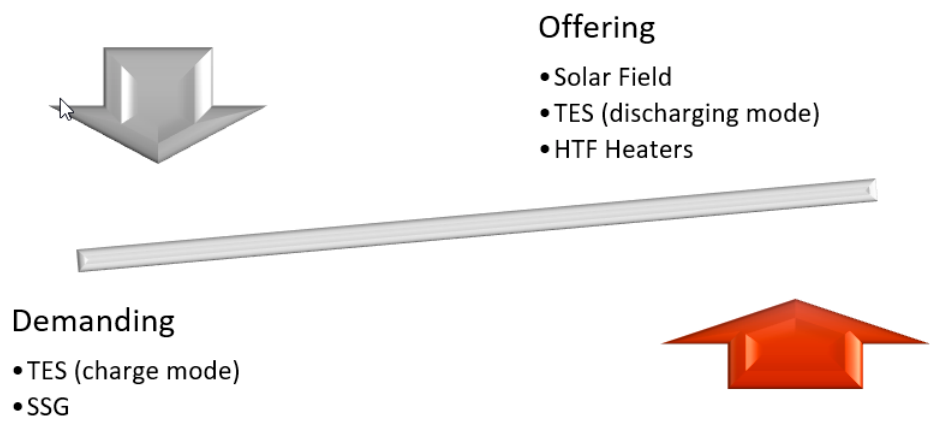
Figure 6. Energy manager system